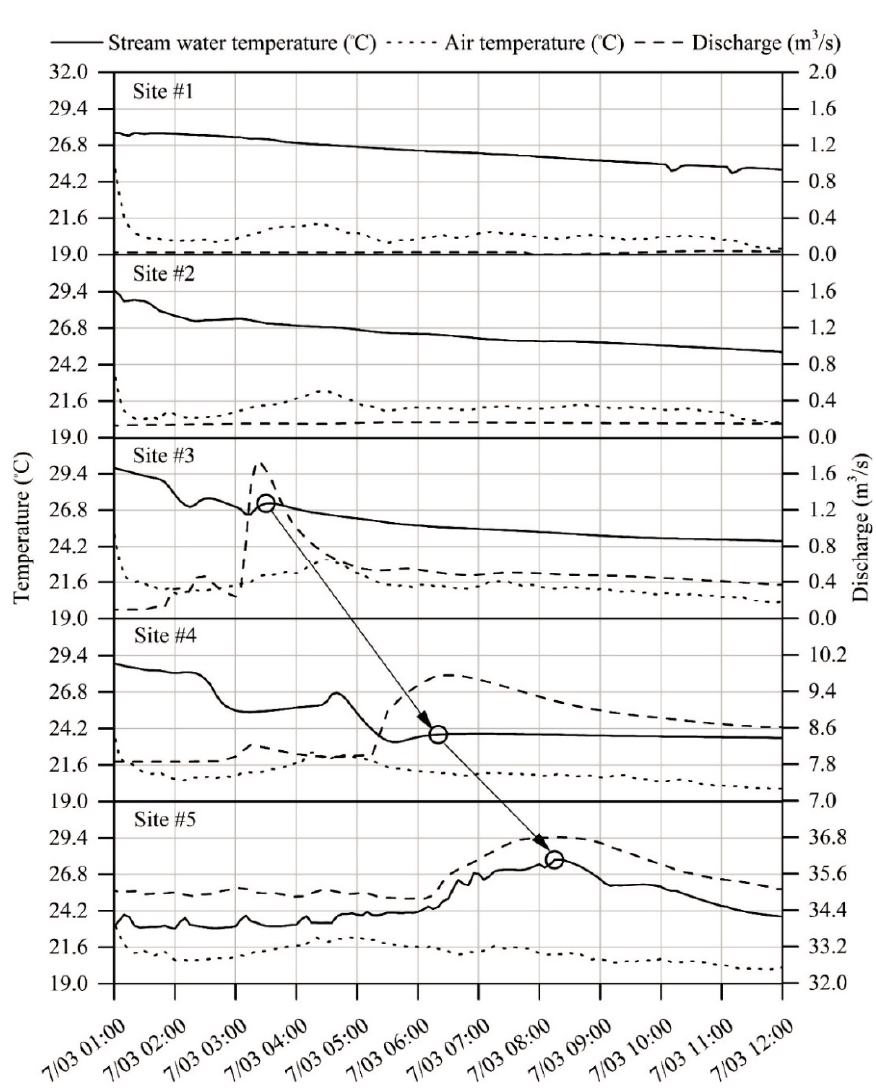
Figure 5. Plume of heated stormwater sensed in Hinkson Creek after a summer thunderstorm during summer 2011. The black circles mark the peak T w after the increase in discharge and the arrows track the event downstream from sites #3 through